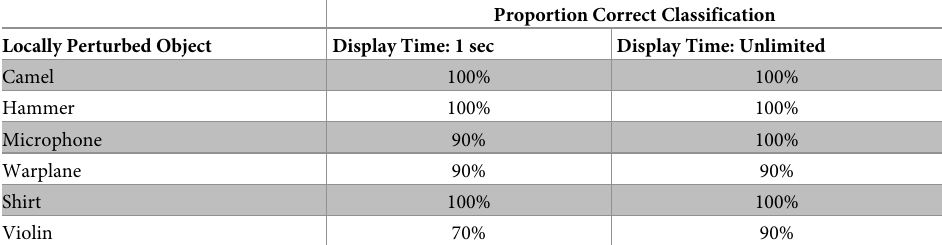
Table 2. Human observers’ performance on individual items for perturbed-contour